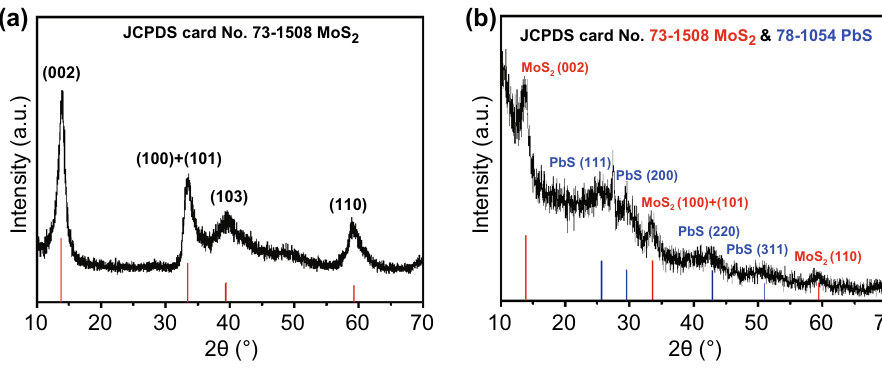
Fig. 3 XRD patterns of a MoS 2 nanosheet and b QD‑sensitized MoS 2